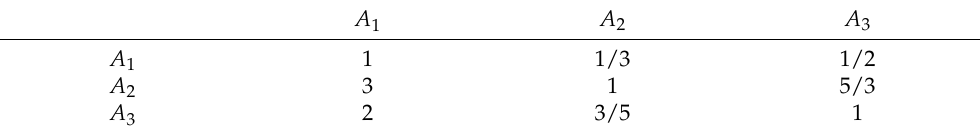
Table 5. Relationship of the importance of three evaluation factors of static obstacle avoidance. A 1 A 2 A 3 A 1 1 1/3 1/2 A 2 3 A